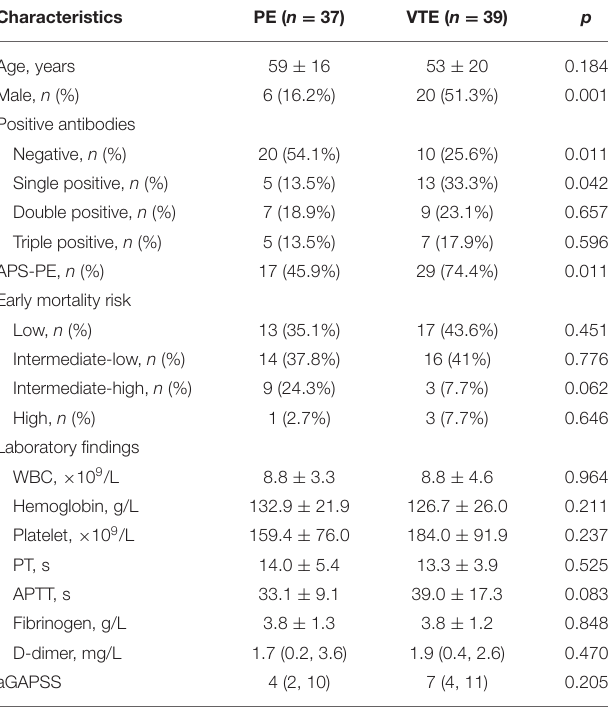
TABLE 2 | Comparison of clinical characteristics between APS-PE and non-APS-PE patients. Characteristics